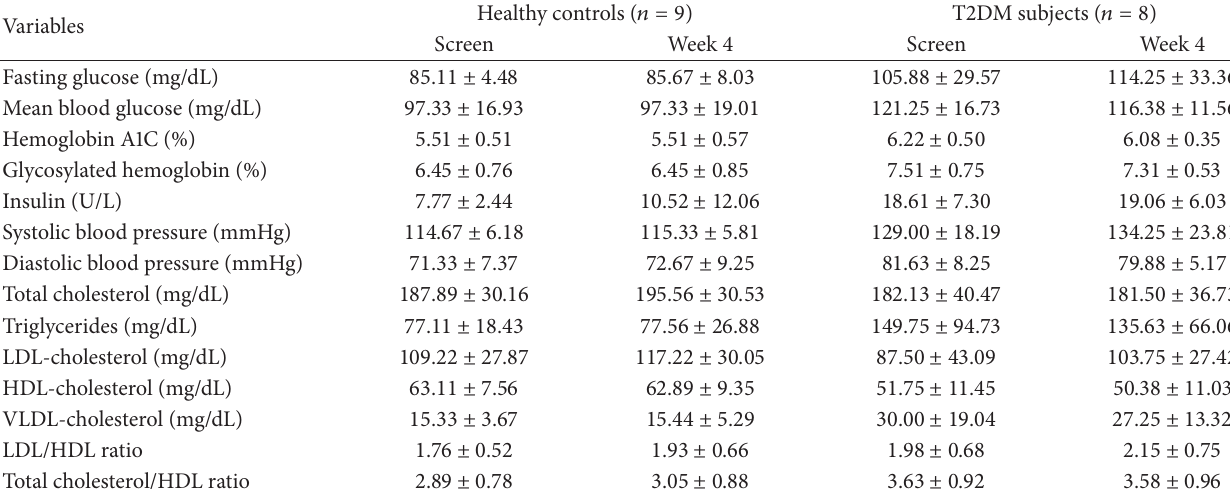
Table 3: Effects of POMx on blood glucose, blood pressure, and lipids 1 .